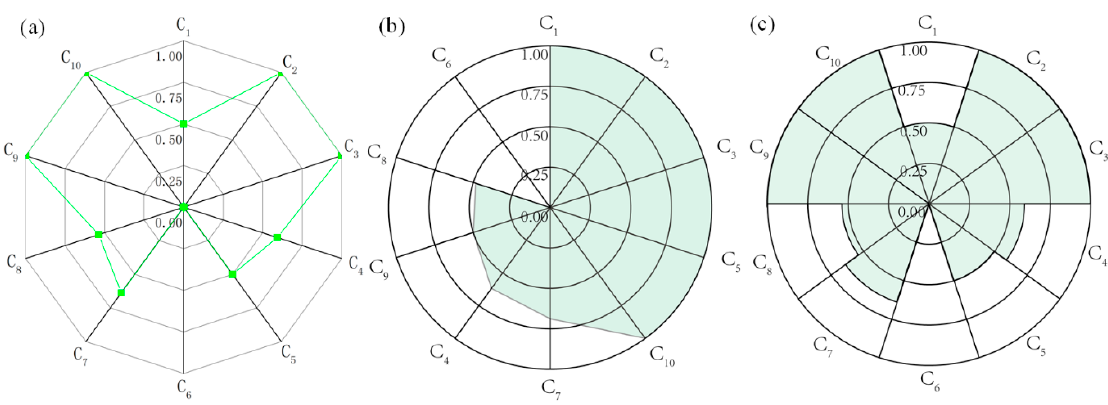
Figure 3. Radar plot ( a ), unit circle ( b ) and modified unit circle ( c) . C 1 –C 10 are ten evaluation indices of stand state respectively.